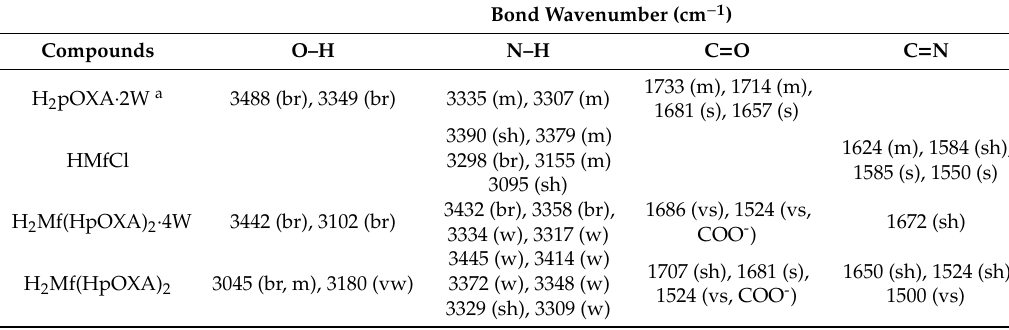
Figure 7. XRPD patterns of ( a ) pristine HMfCl, ( b ) H 2 Mf(HpOXA) 2 ∙ 4W organic salt simulated from single crystal X-ray data, ( c ) H 2 Mf(HpOXA) 2 microcrystalline powder and ( d ) after rehydration from H 2 Mf(HpOXA) 2 . Table 4. Stretching IR absorptions of solid powders of compounds H 2 pOXA, HMfCl, H 2 Mf(HpOXA) 2 · 4W and H 2 Mf(HpOXA) 2